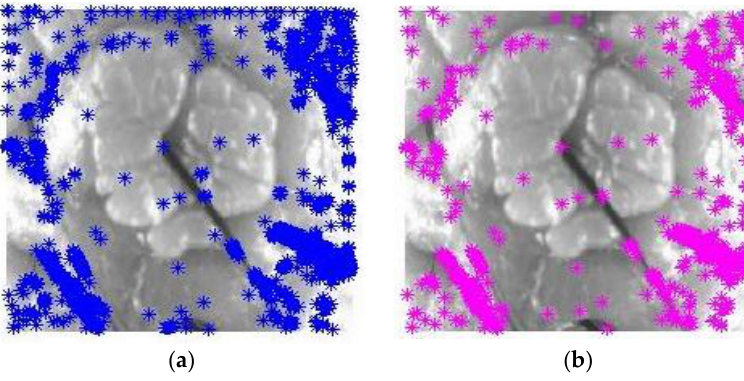
Figure 14. ( a ) Before the operating threshold method; ( b ) after the operating threshold method. Appl. Sci. 2018 , 8 , x